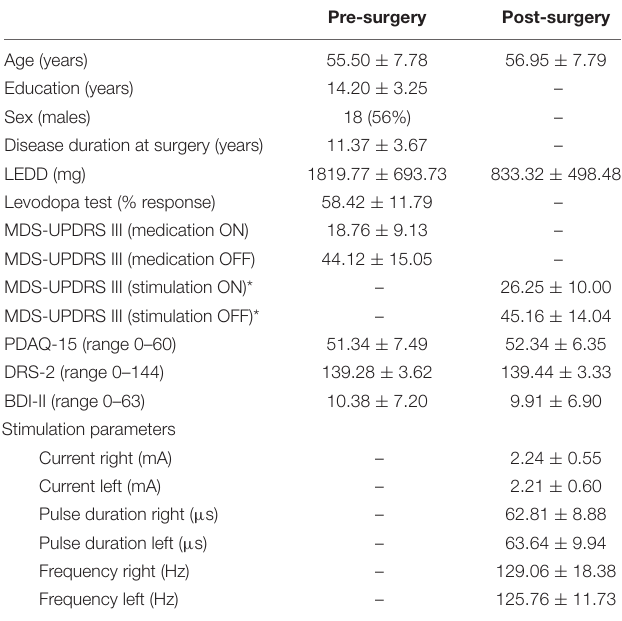
TABLE 1 | Demographic, clinical, and cognitive characteristics of the sample ( N =